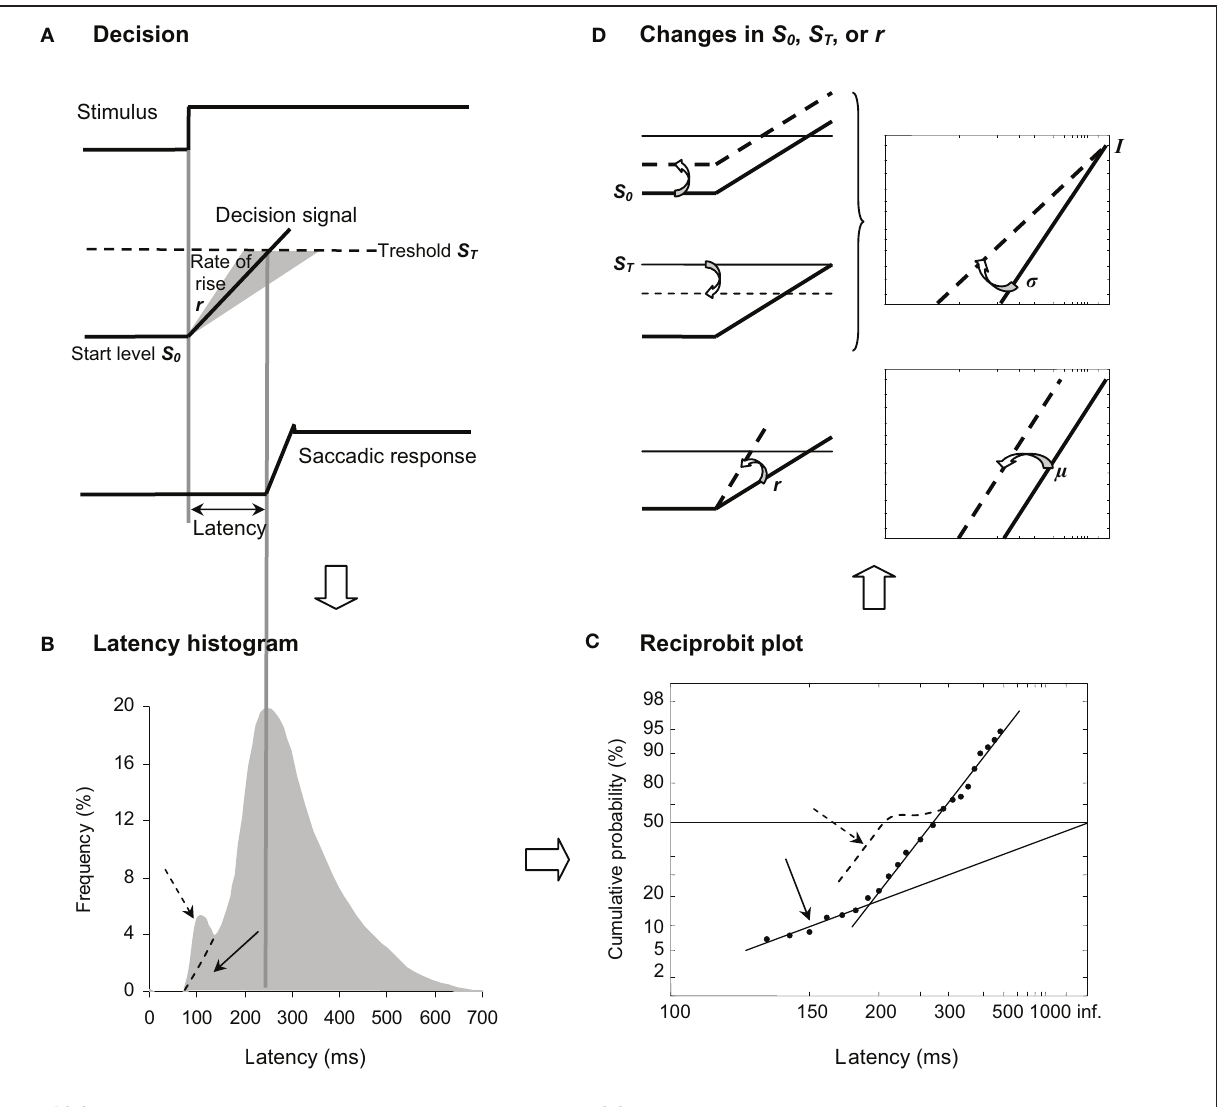
(C) Resulting reciprobit plot of Cumulative probability on a probit scale (in %) as a function of Latency on a reciprocal scale (in ms). The main recinormal distribution lies on a straight line described by μ and σ . Early saccades can occur lying a second line described by σ (cid:4) (full arrow), while express saccades (dashed arrow) might exhibit a specific pattern (see Text). (D) Changes that can occur in LATER. A change in the distance between S 0 and S T results in a swivel of the recinormal distribution around the intercept (up). A change in the rate of rise r results in a lateral shift of the recinormal distribution (down).